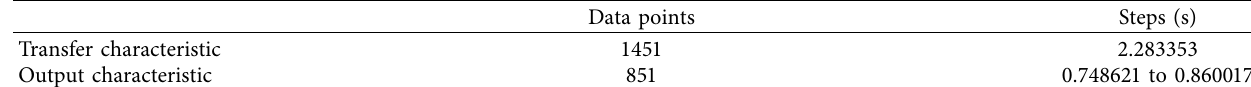
Table 3: GA numerical